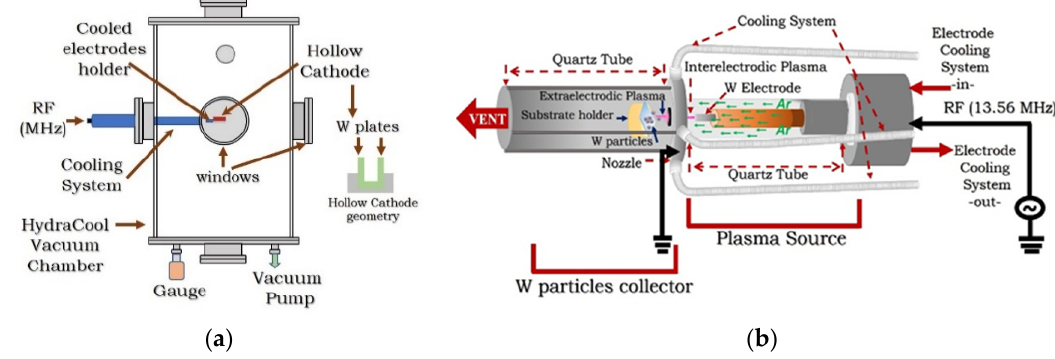
Figure 1. Schematic views of: ( a ) Hollow-Cathode setup configuration, and ( b ) Microjet discharge configuration.